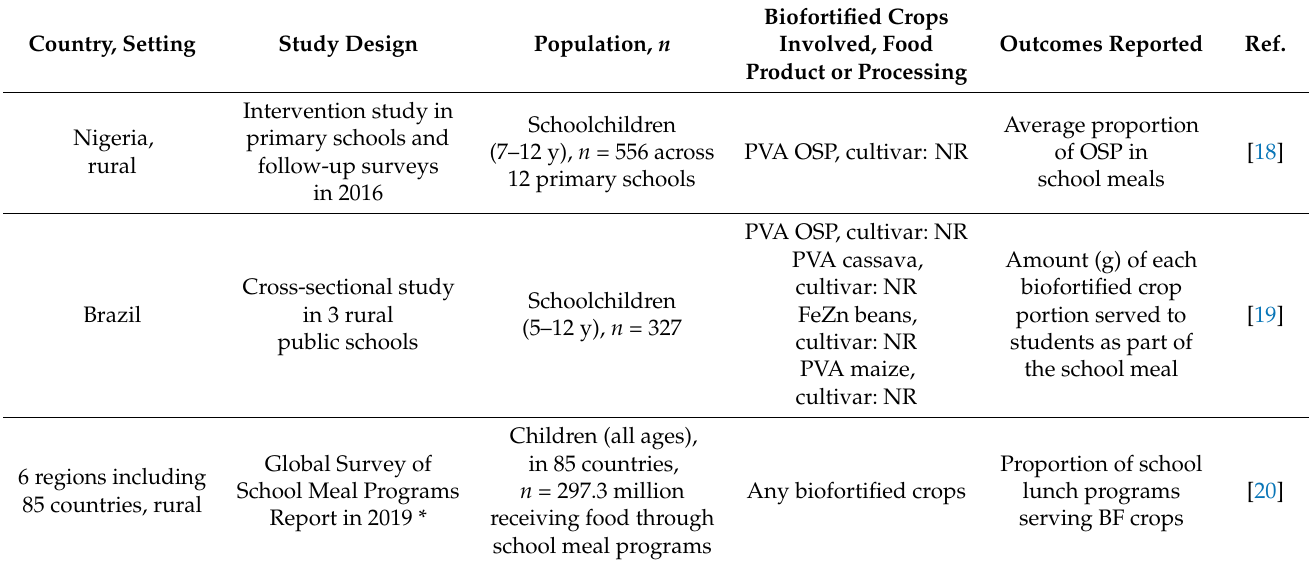
Table 5. Characteristics of included studies for Impact Pathway 3, Formal